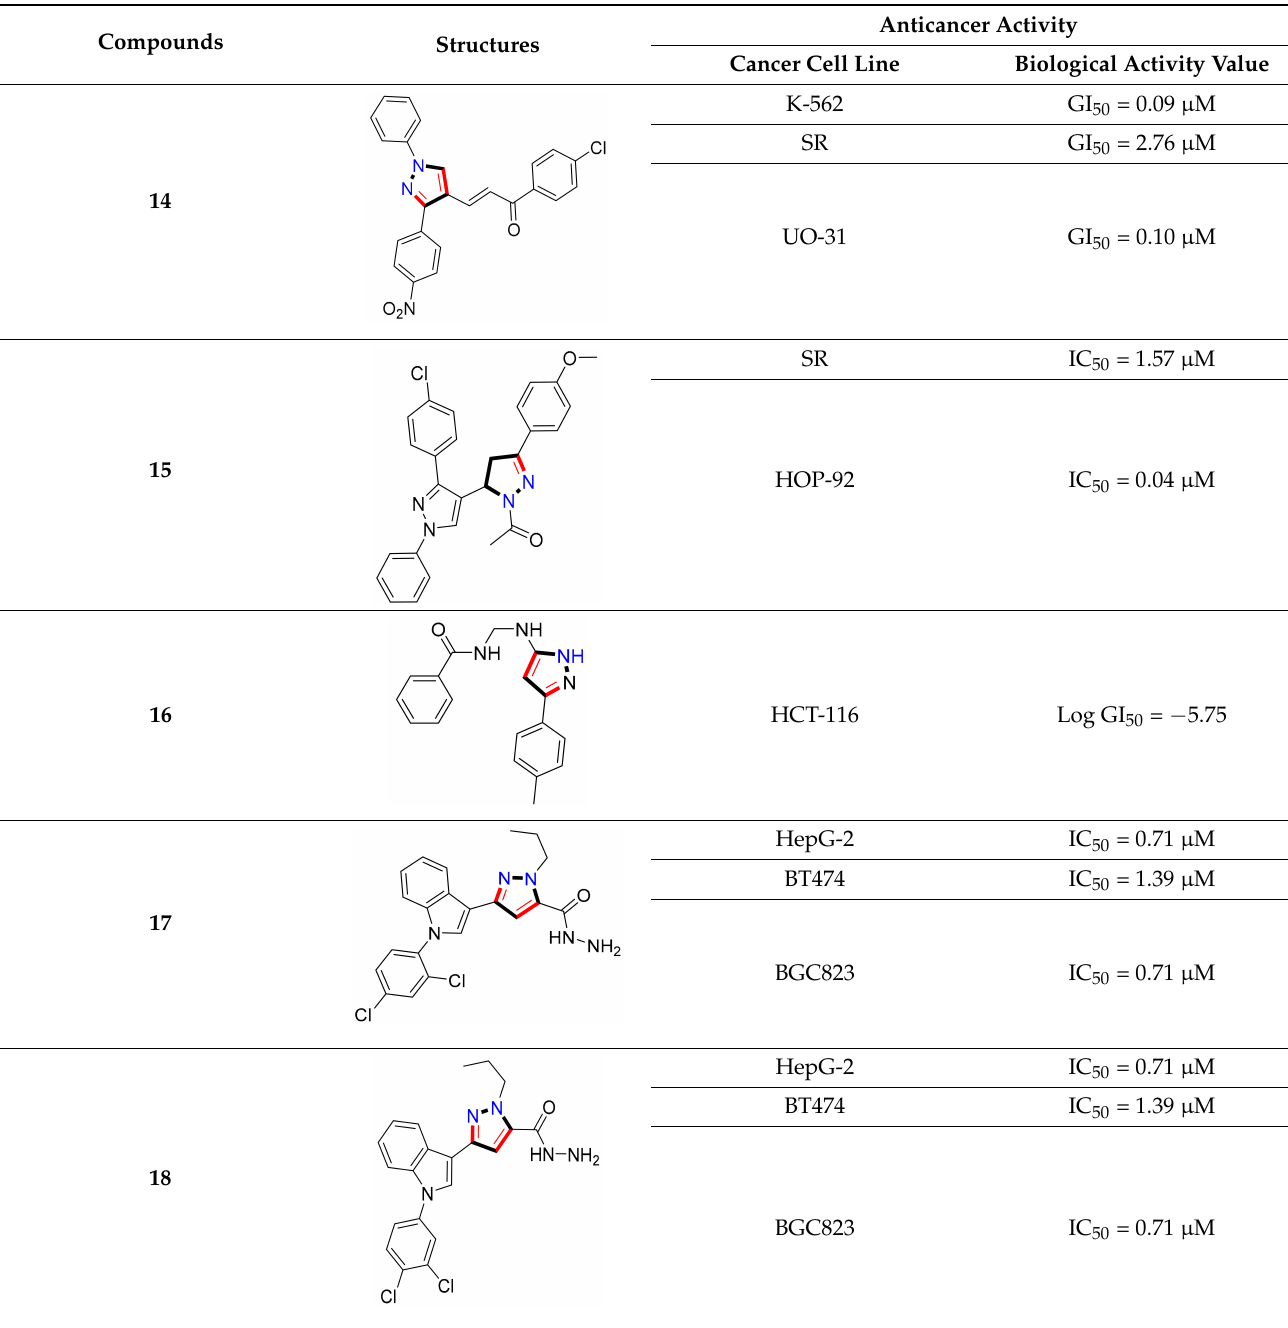
yl)methyl) aniline-containing derivatives were explored by Huang et al., who assessed them for anticancer potential and cyclin-dependent kinase-2 (CDK2) inhibitory properties in vitro, with an IC 50 of 0.98 ± 0.06 µ M. Compound 20 reflected excellent anticancer po- tential against MCF-7 with IC 50 values of 1.88 ± 0.11 and B16-F10 cancer cell lines with IC 50 = 2.12 ± 0.15 µ M [43]. Compound 21, displaying significant anticancer efficacy